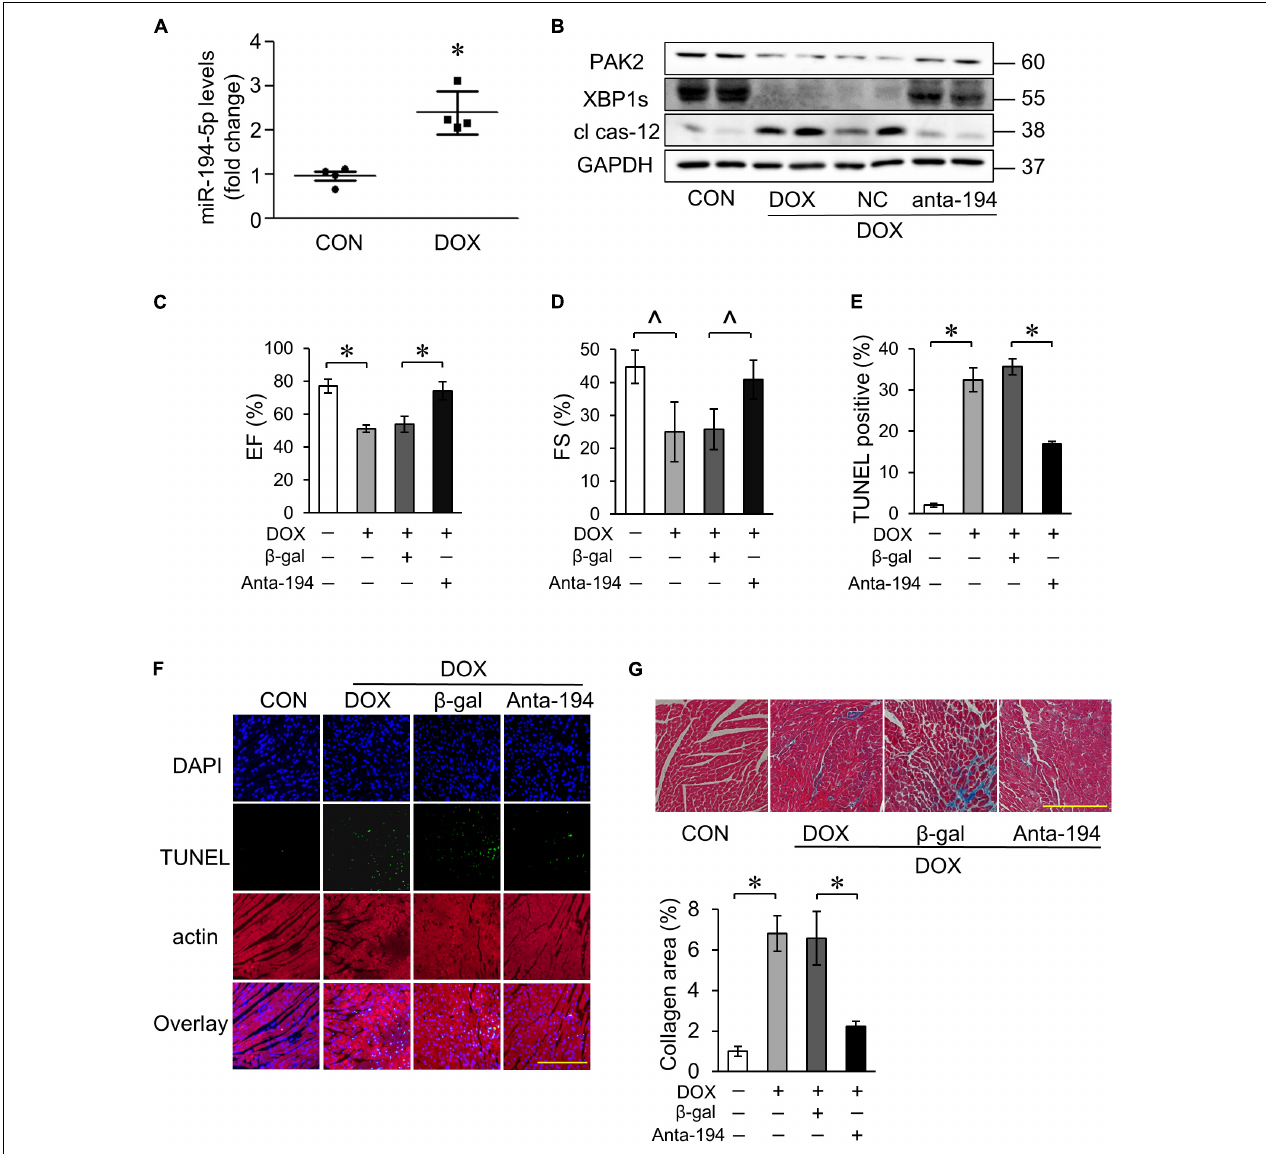
FIGURE 7 | MiR-194-5p was involved in DOX-induced cardiotoxicity in vivo . (A) The expression levels of miR-194-5p in mice heart tissue were detected after DOX treatment by qRT-PCR. (B) Adenovirus-harbored anta-miR-194-5p was injected into the mice 1 week before DOX treatment. The expression levels of PAK2, XBP1s and cleaved caspase-12 were detected by Western blot. Echocardiographic analysis of left ventricular cardiac function in mice, EF (C) and FS (D) results are shown. EF, ejection fraction; FS, fractional shortening. Apoptosis was measured by TUNEL assay (F) and apoptotic rates were analyzed (E) . Green, TUNEL-positive nuclei; blue, DAPI (4,6-diamidino-2-phenylindole)-stained nuclei; scale bar, 500 µ m. (G) Masson trichrome staining for collagen performed. scale bar, 200 µ m. Anta-194, adenovirus-harbored miR-194-5p antagomir. N = 4, and the data were expressed as mean ± SD. ∧ p < 0.05 vs. control. ∗ p < 0.01 vs.